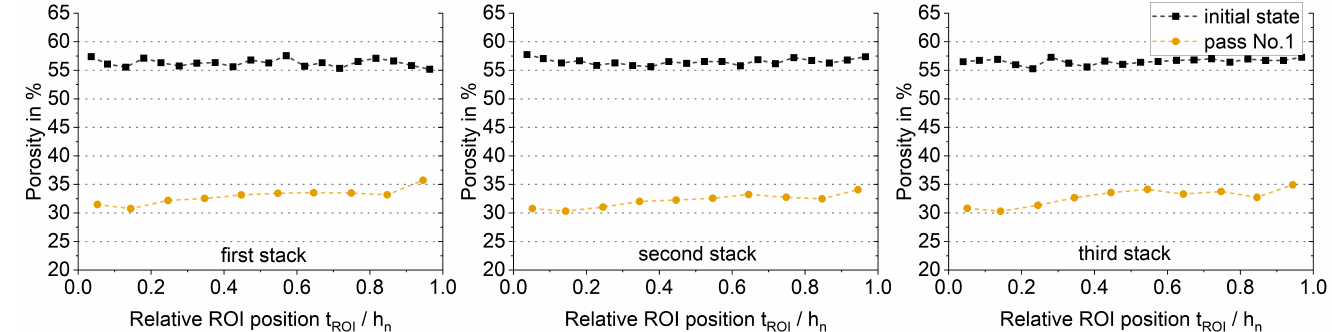
Figure 9. Series I: 5-0.50-20 ( l d / h m ≈ 0.8 − 1.2): Porosity change over relative sample depth (0=upper surface; 0.5= mid-section of sample; 1 =lower surface) due to rolling for first, second and third stack.